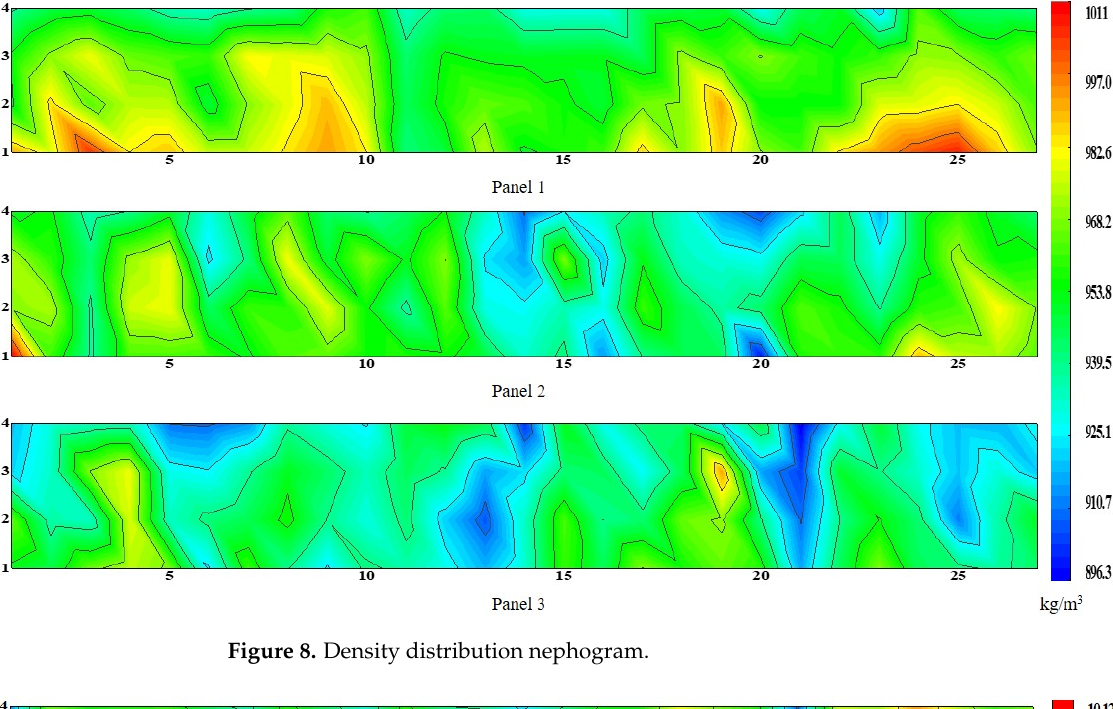
Figure 8. Density distribution nephogram.